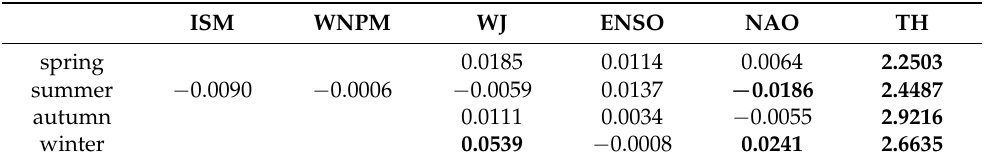
Table 3. Seasonal trends of climate system indices. Bold fonts represent statistically significant trends ( p <